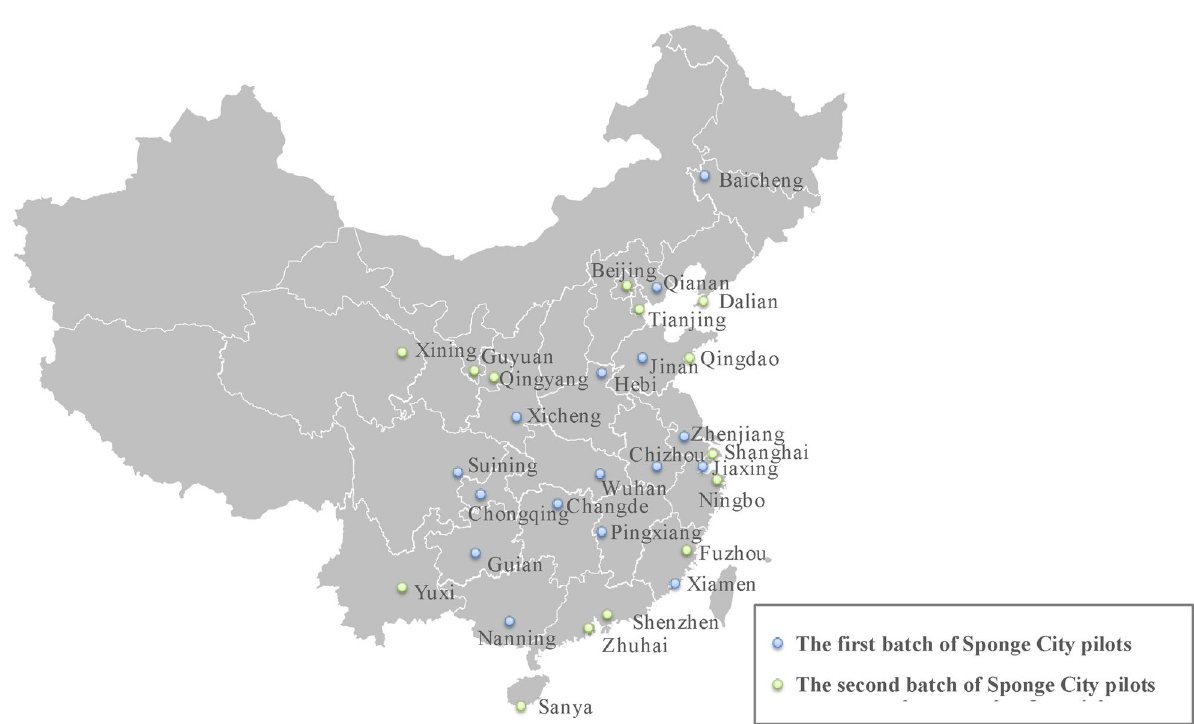
Figure 2. Statistics of Sponge City